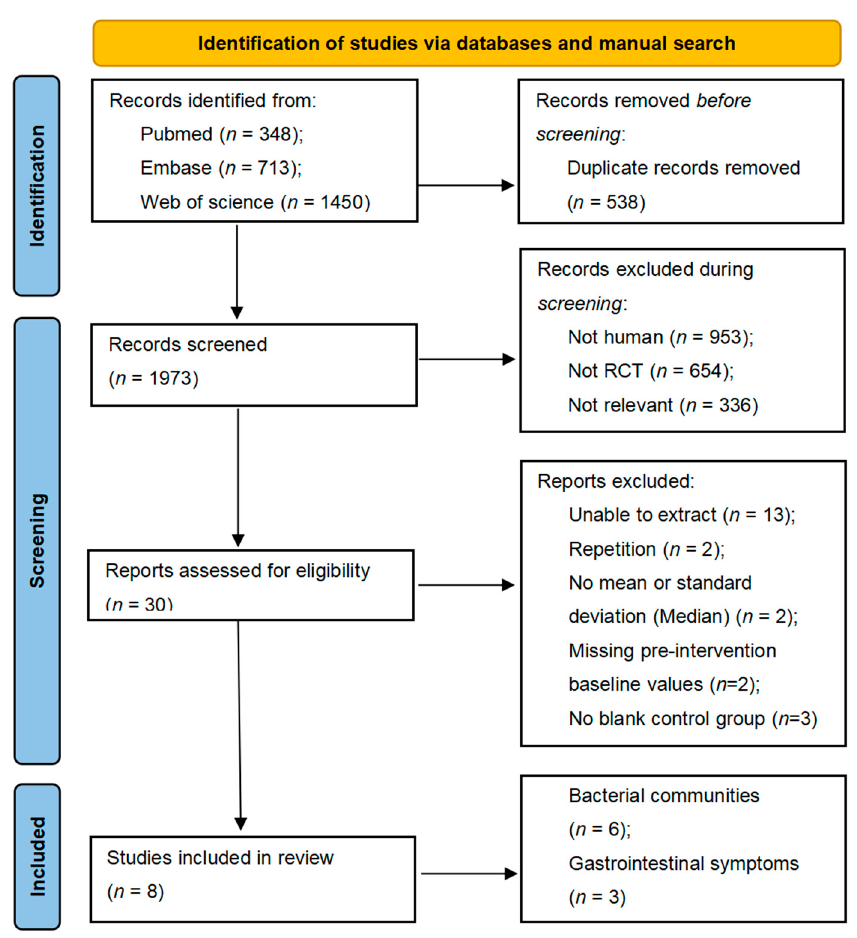
Figure 1. Flow chart of the included studies.